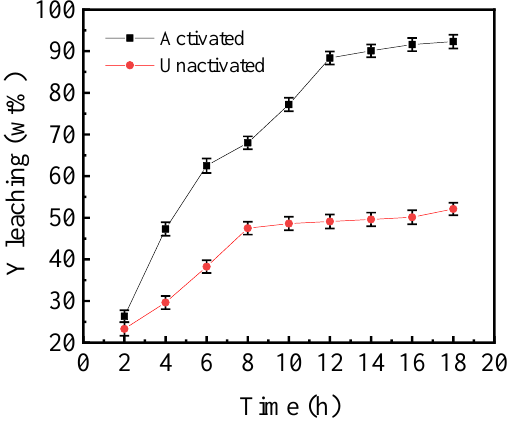
Figure 5. The effect of mechanical activation and leaching time on leaching efficiency (T = 80 °C, t MA = 60 min).